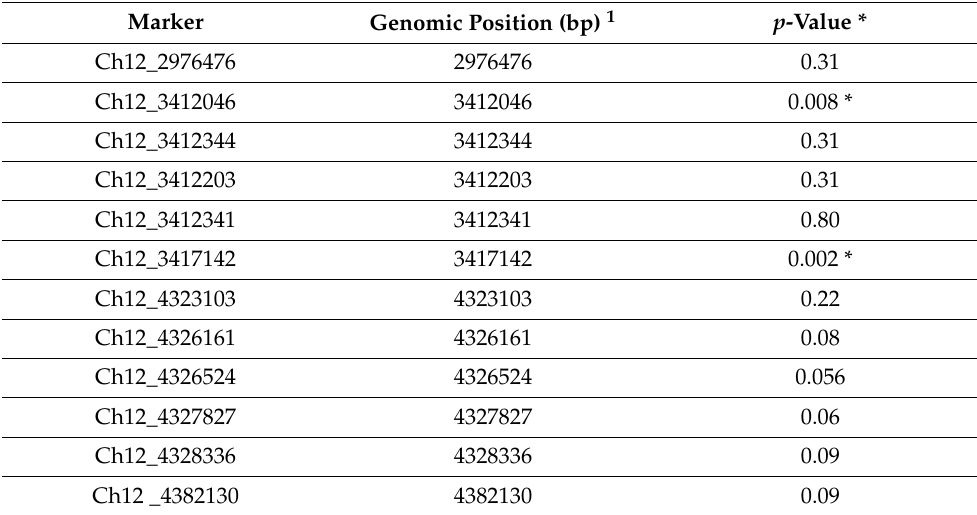
Table 4. Chromosomal position and Kruskal–Wallis test p -values of SNP markers tested for association with hull-less seed trait in cultivars and land races of diverse genetic backgrounds.